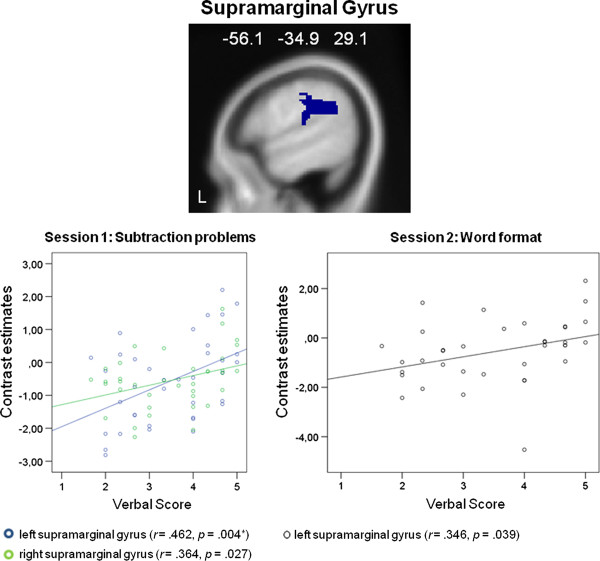
ROI analysis results: Supramarginal Gyrus. Significant correlation between peak activations in the supramaginal gyrus and the self-reported use of verbalization: In the first functional session significant correlations appeared for the subtraction problems and the right and left [* correlation passes the Bonferroni correction (critical p value is .006)] supramarginal gyrus. In the second functional session a significant correlation appeared for multiplications presented with written number words and the left supramarginal gyrus.